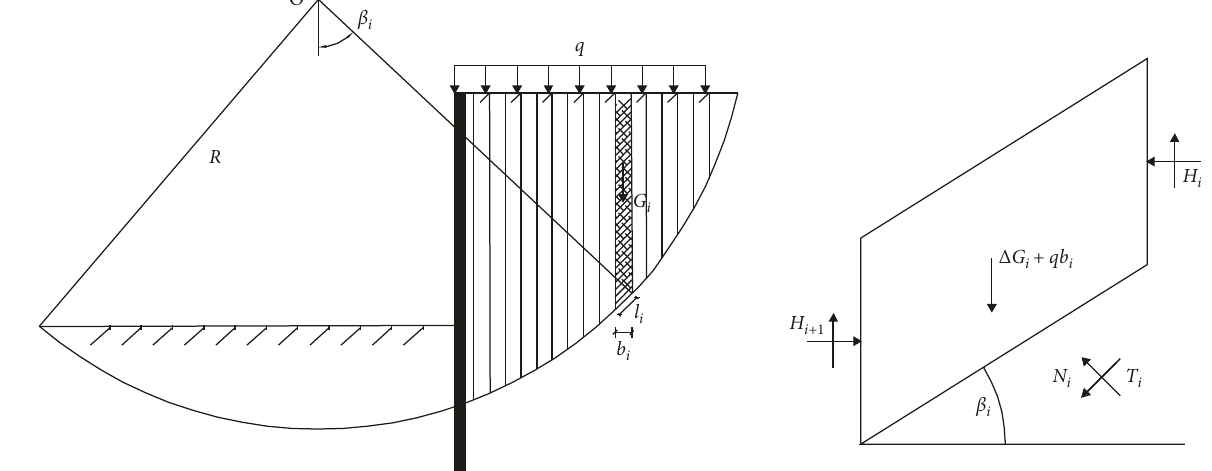
Figure 1: Analysis and calculation of overall stability of foundation pit.